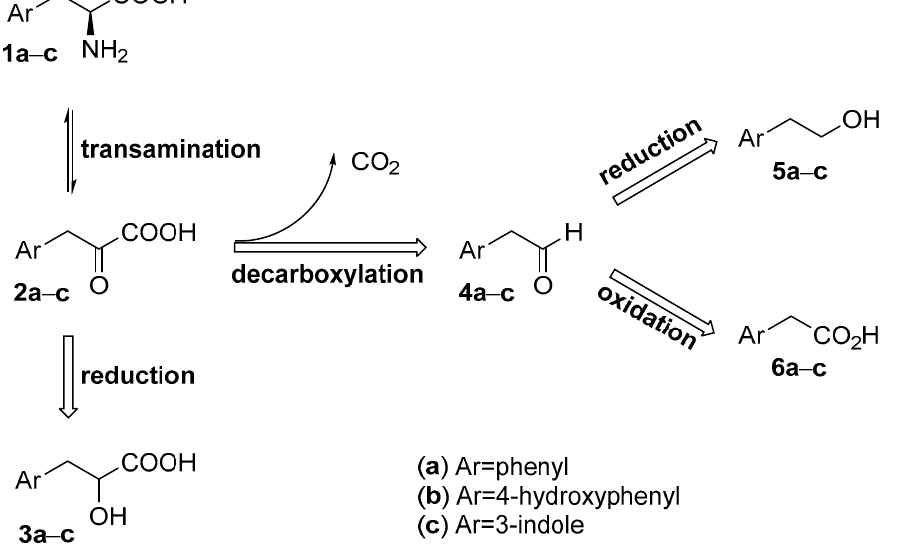
Figure 1. The biotransformation of the amino acids (L)-phenylalanine 1a , (L)-tyrosine 1b and (L)-tryptophan 1c through Ehrlich pathway.